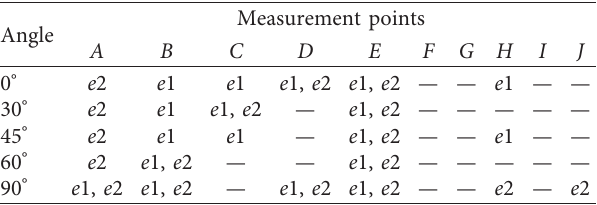
Table 6: Statistical table of strain characteristics of all measurement points in each group. Measurement points Angle